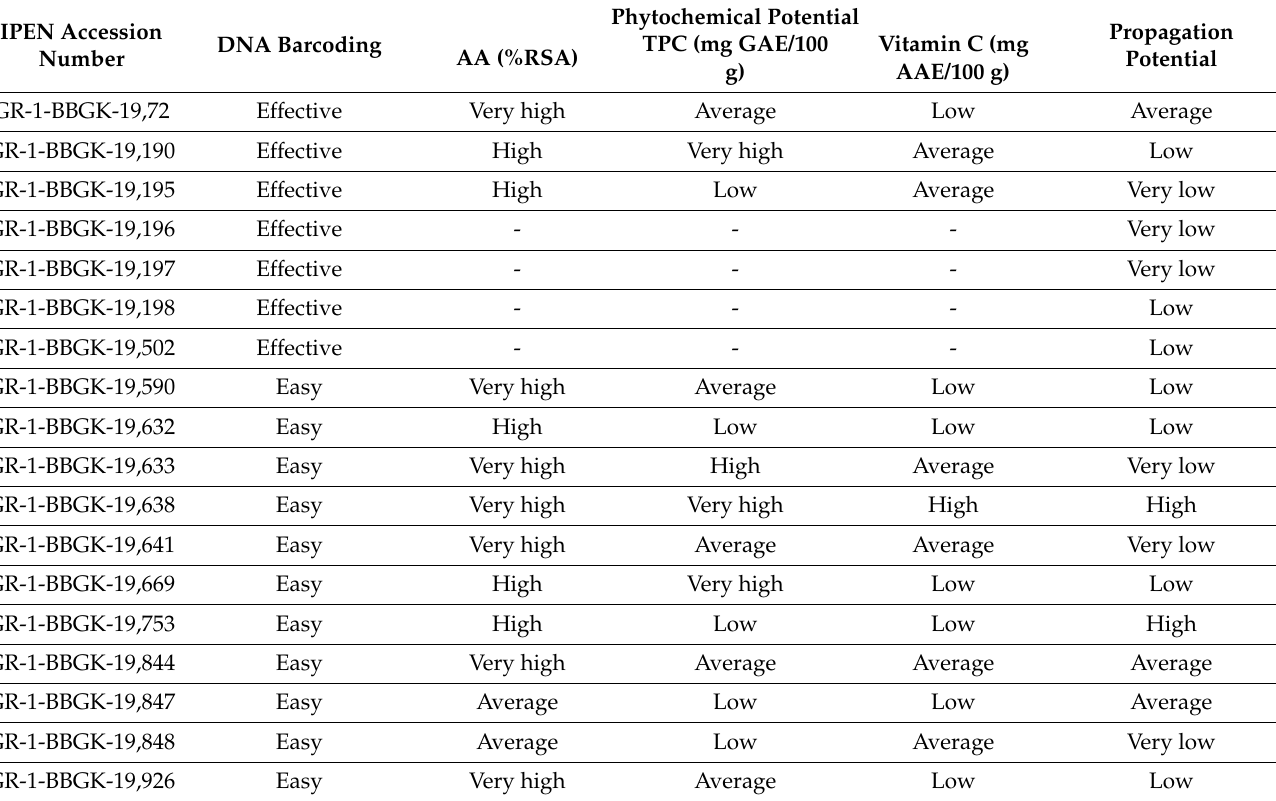
Table 4. Multifaceted evaluation of Greek native Cornus mas genotypes based on molecular au- thentication effectiveness (Figure 1), fruit phytochemical potential expressed as antioxidant activity (AA, %RSA: low ≤ 50, average 51–70, high 71–90, very high >90), total phenolic content (TPC, mg